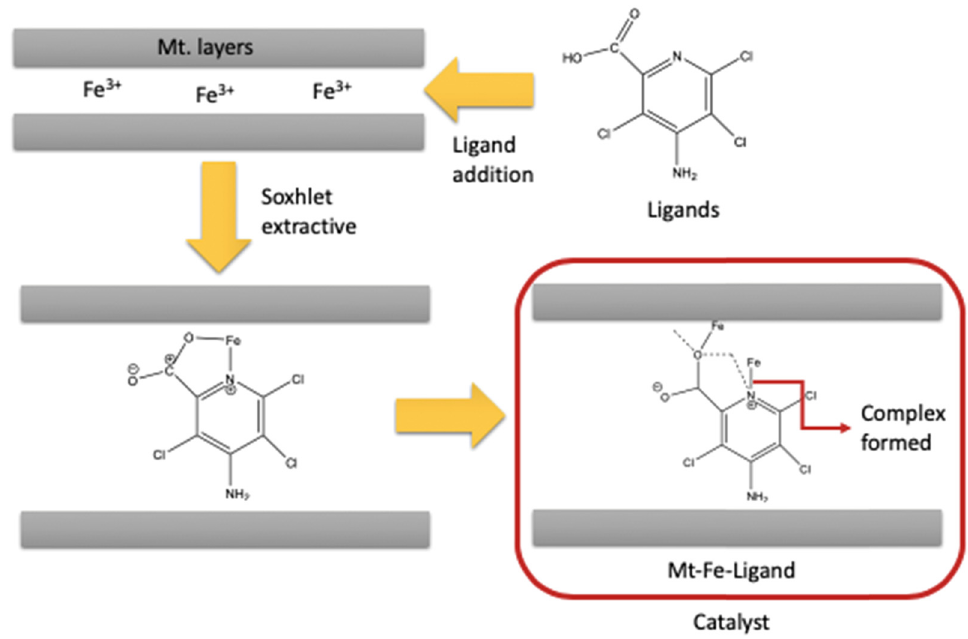
Figure 6: Schematic representation of the photocatalysis mechanism over combination with the supporting form, has proven e ff ective in improving the separation e ffi ciency of photo - induced electron – hole pairs. According to the method given in Figure 7, as MNP and MICNC photo - catalysts are exposed by photons, electrons are excited from the valence band ( VB ) to the conductance band ( CB ) , leading to the formation of a hole ( h + ) in the VB. The interaction between h + and e − in each CB and VB from the reaction system or solvent with OH and O 2 produces radicals for further oxidation.